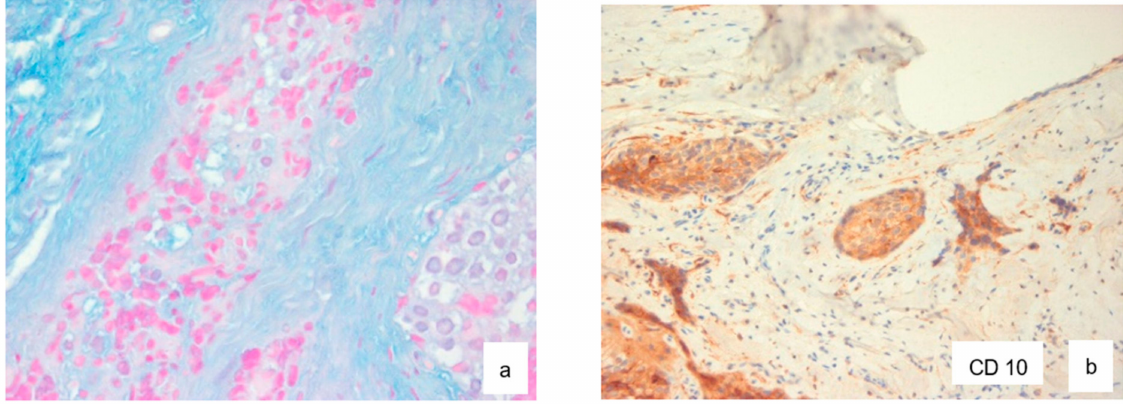
Figure 5. Alcian Blue staining (( a ), × 40) and CD 10 immunohistochemistry (( b ), ×